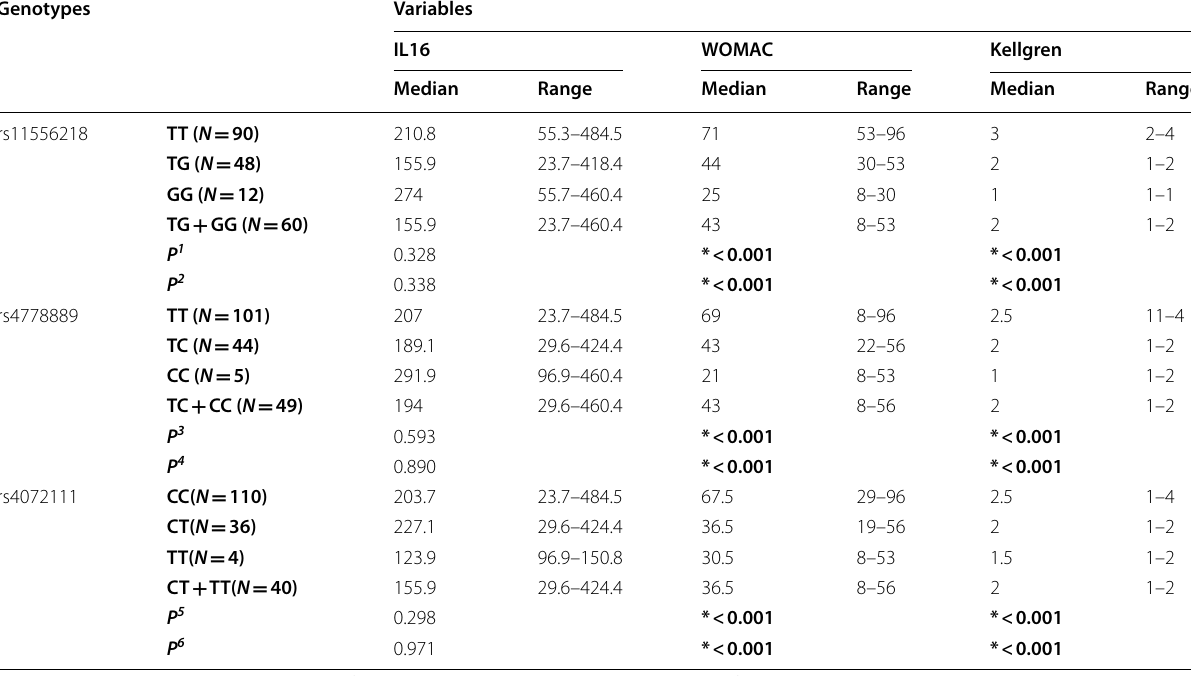
Table 4 Association of IL16 level, WOMAC, and K/L score with IL16 genotypes